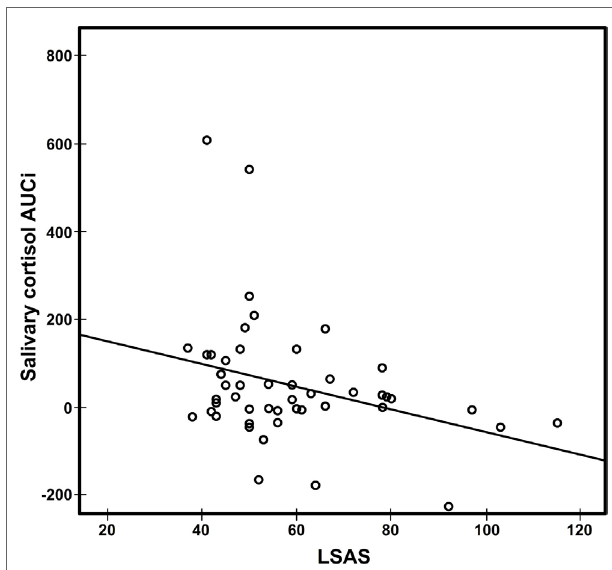
FigUre 3 | scatter plot of salivary cortisol aUc i against lsas scores ( r s = − 0.29, p = 0.021) . AUC I , area under the curve relative to increase; LSAS-SR, Liebowitz Social Anxiety Scale.